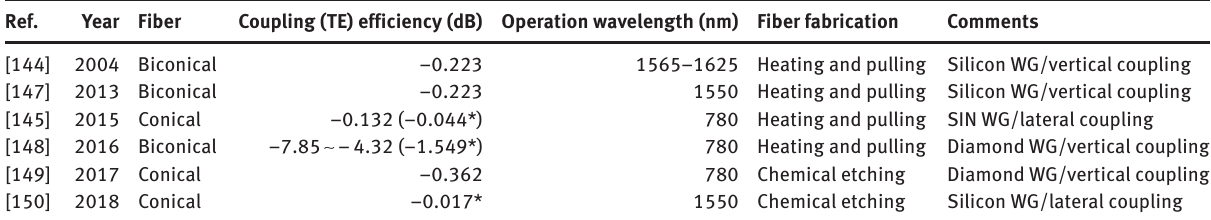
Table 3: Summary of the reported adiabatic coupling methods.